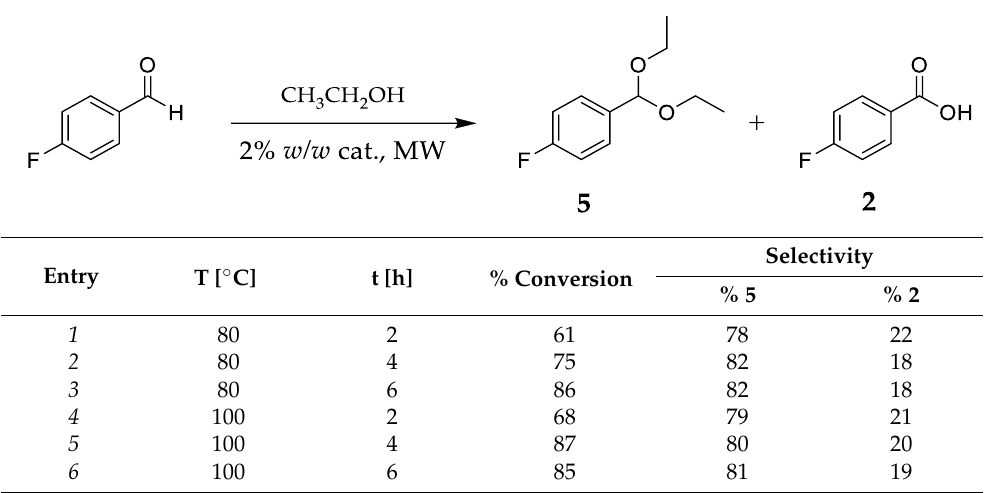
Table 10. Reactions with different carbonyl compounds using ethanol as solvent *.